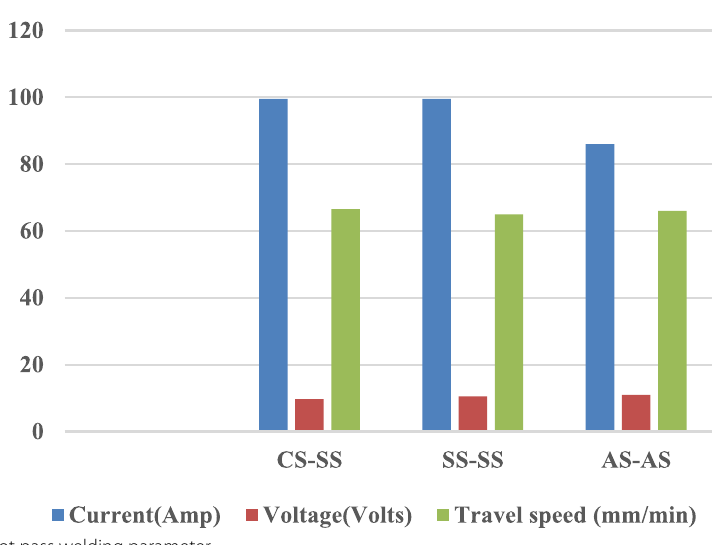
Fig. 6 Hot pass welding parameter